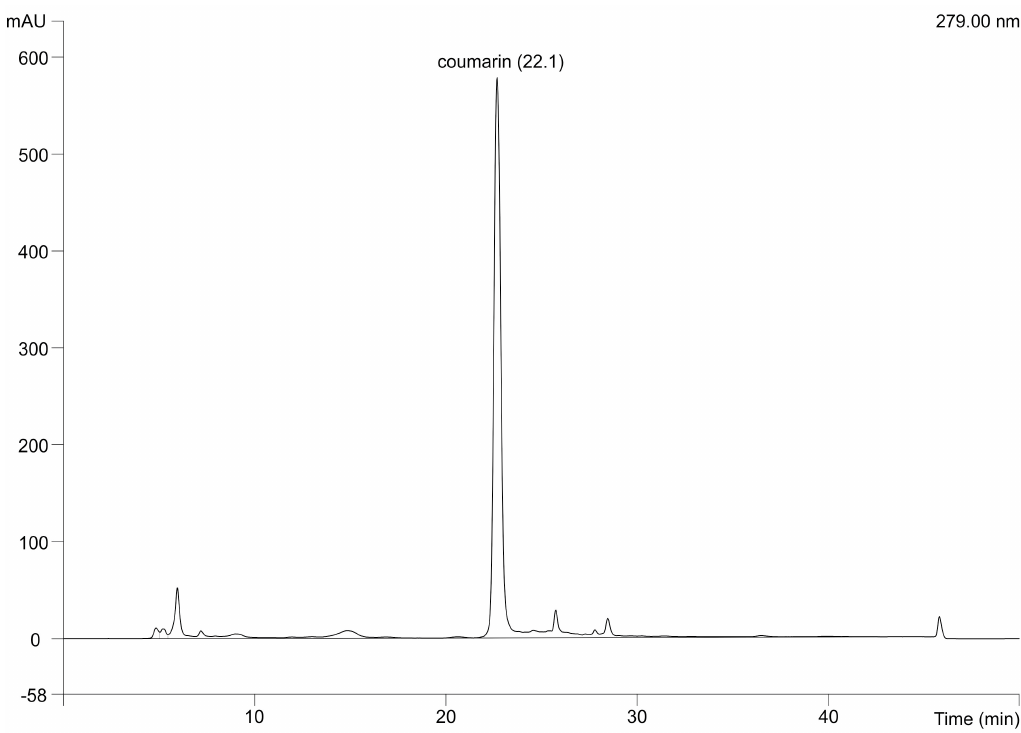
Figure 1. The chromatogram of M. officinalis L. extract obtained with 96% EtOH (mAU: milli absorbance unit). Figure 1. Thechromatogramof M.officinalis